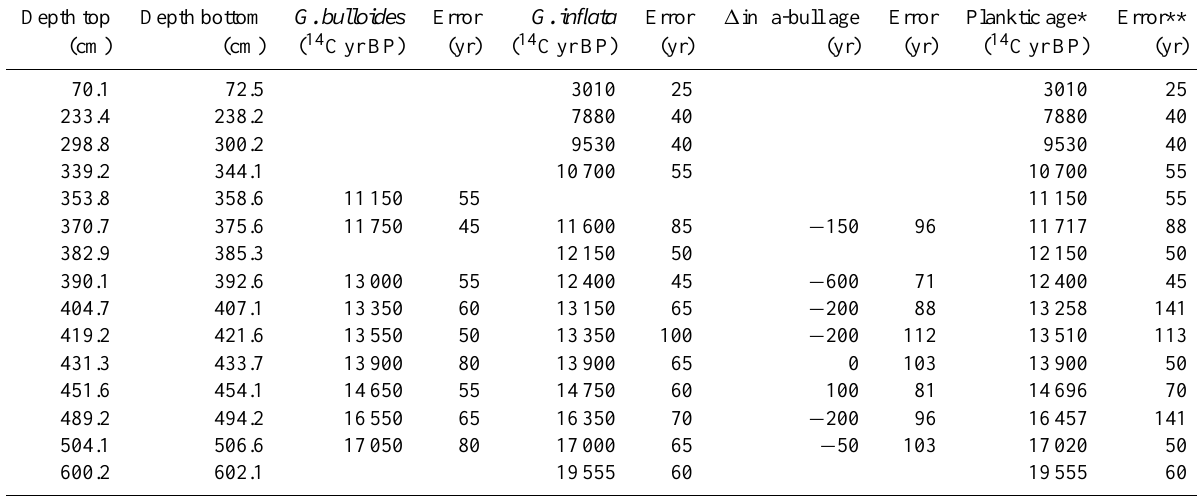
Table 3. Radiocarbon ages of planktic foraminiferal species Globigerina bulloides and Globorotalia inflata in core MD01-2420. Depth top